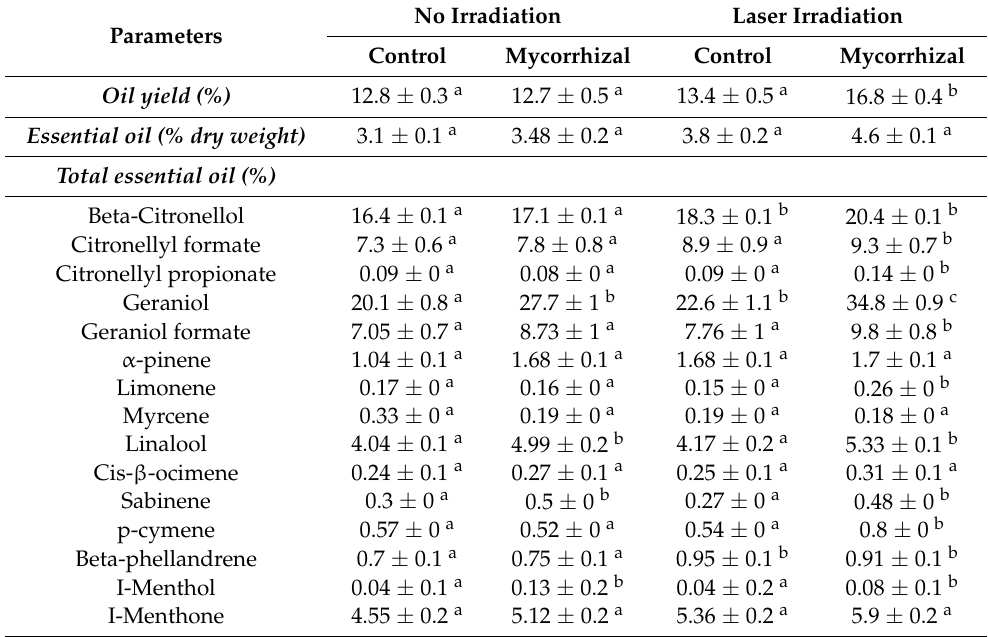
Table 4. Essential oil content in control and treated P. graveolens